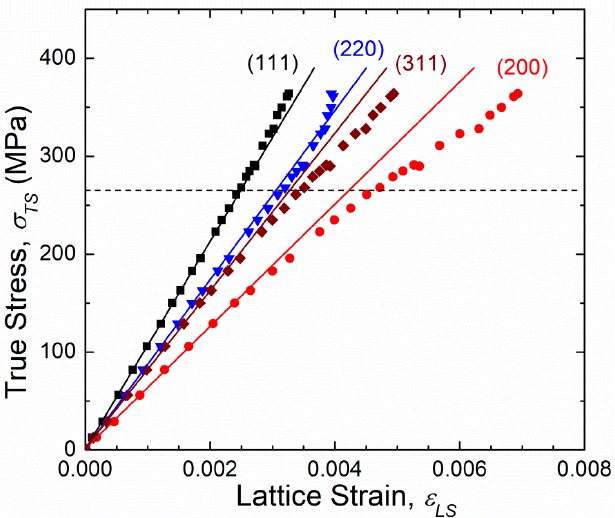
Figure 4. Macroscopic stress ( σ TS ) plotted against microscopic lattice strain ( ε LS ) for reflections of (111), (200), (220) and (311) of nc-Ag. Horizontal dashed line: the macroscopic yield strength, 265 MPa, of nc-Ag. Solid lines: elastic stress-strain relations.